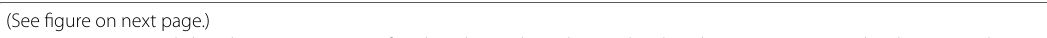
(See figure on next page.) Fig. 3 DSS protected chondrocytes against IL-1β-induced ECM degradation. The chondrocytes were treated with 2.5, 5, and 10 μM DSS for 24 h and then stimulated by 10 ng/ml IL-1β for 2 h. A , B Protein levels of MMP3, MMP13, ADAMTS4, ADAMTS5, aggrecan, and collagen II in chondrocytes ( A ), and their quantification by the Quantity ONE software ( B ). C , D Representative fluorescence images of collagen II and MMP3 detected by immunofluorescent staining assay ( C ) and the percentage of cell immunofluorescence in chondrocytes that were pretreated with 10 μM DSS for 24 h and stimulated by 10 ng/ml IL-1β for 2 h ( D ). Scale bar 50 μm. *p < 0.05, **p < 0.01, and ***p < =